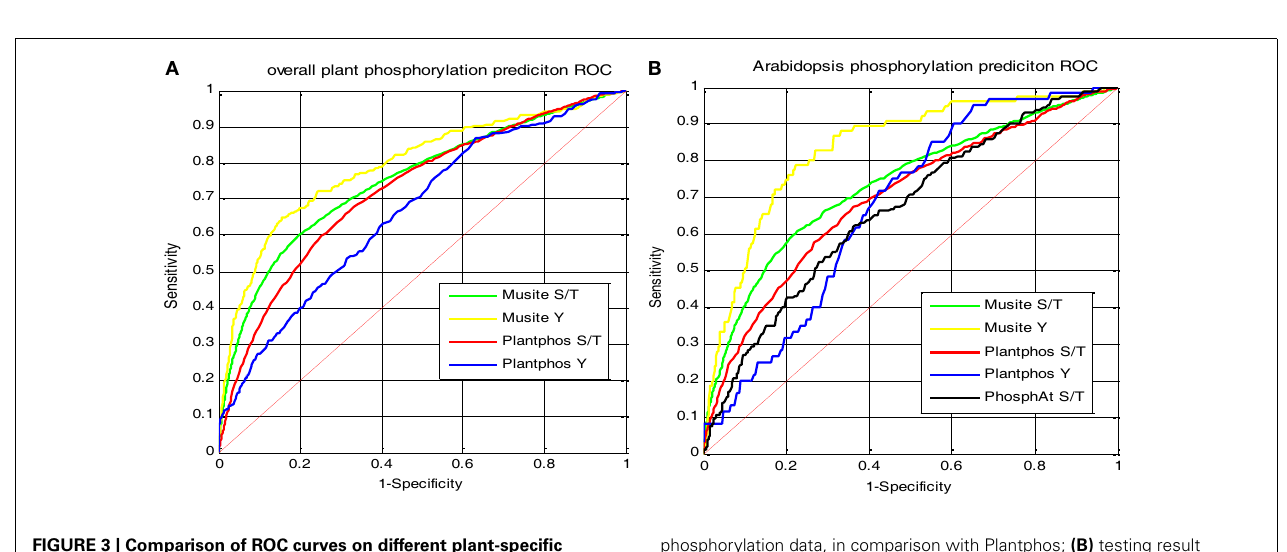
FIGURE 3 | Comparison of ROC curves on different plant-specific tools. For Musite, the training set is on 3/4 of the total phosphorylation data from six organisms. (A) Testing result on the rest of 1/4